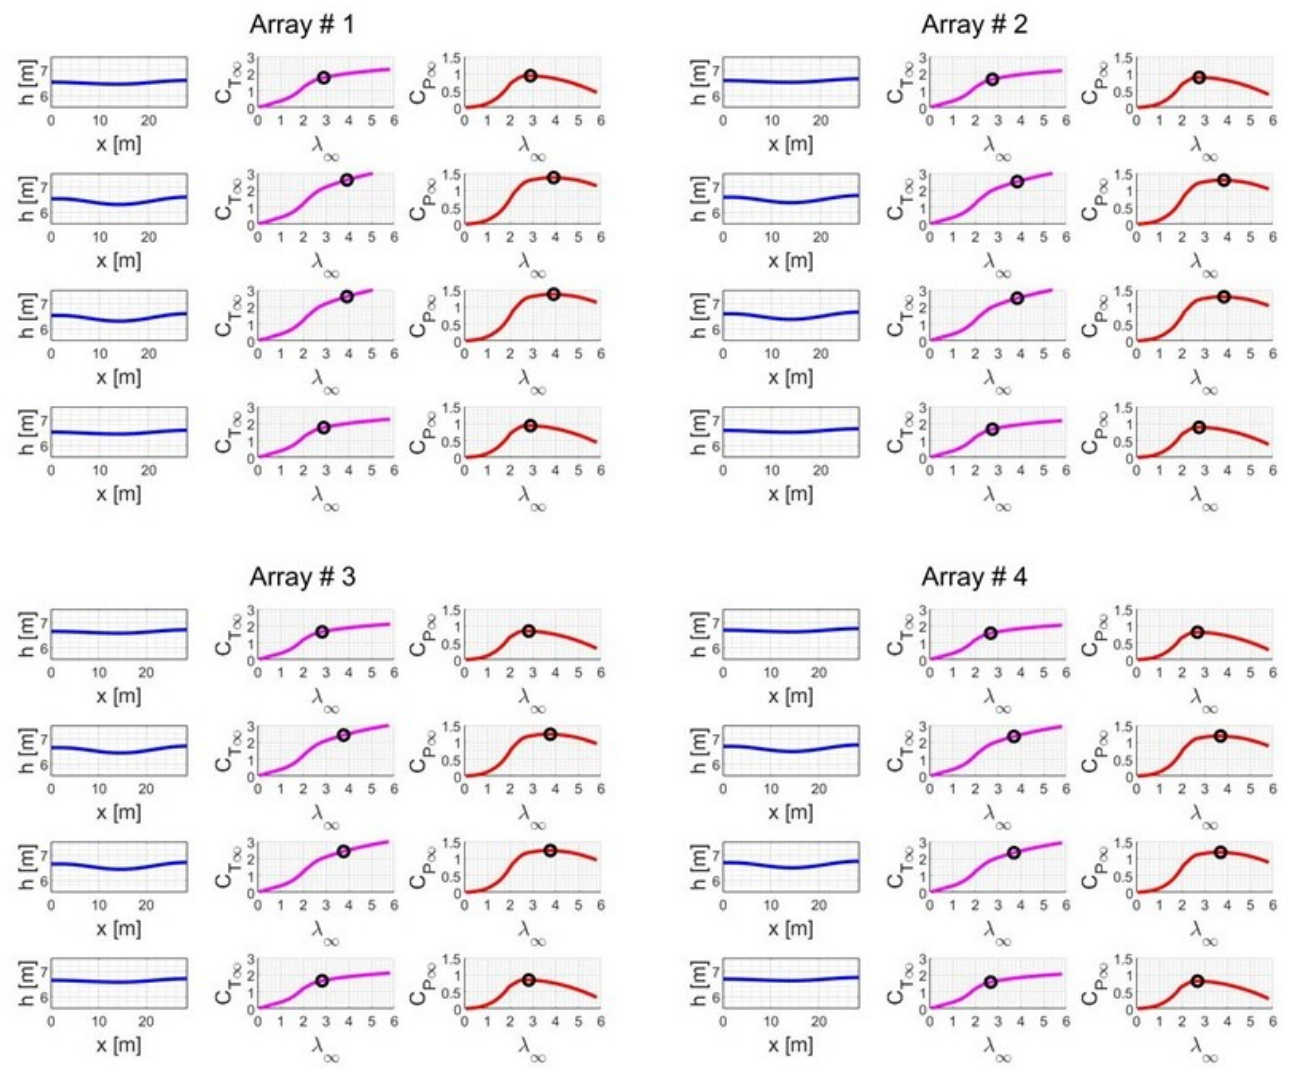
Figure 13. Optimum design: 4 arrays of 4 turbines with AR = 1.5 operating at λ ∞ ,opt . The left column indicates the local free surface deformation in space for each turbine with flow directed from right to left. The central and last columns represent turbine thrust coefficient C T, ∞ and power coefficient C P, ∞ , respectively, for each turbine of the array.